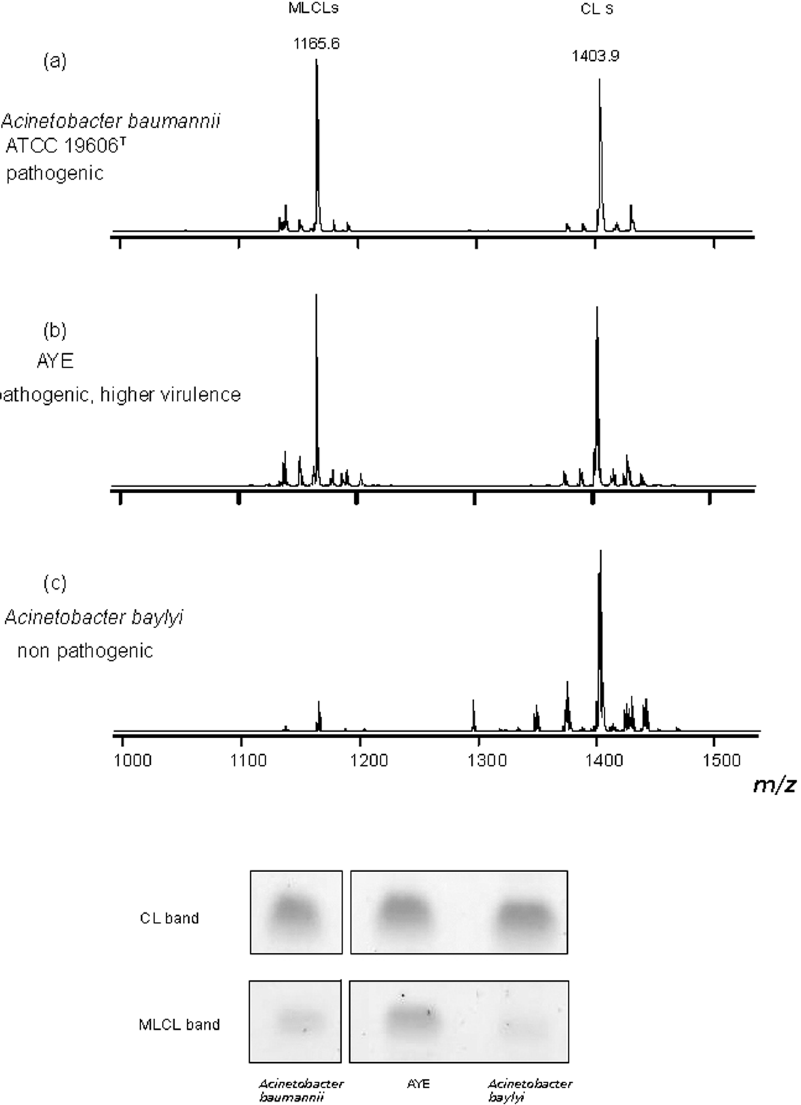
Figure 7. MLCL and CL levels of A . baumannii , AYE and A . baylyi . The lipid analyses of high and low virulence cells have been performed by combining mass spectrometry and TLC. Mass spectra were acquired in